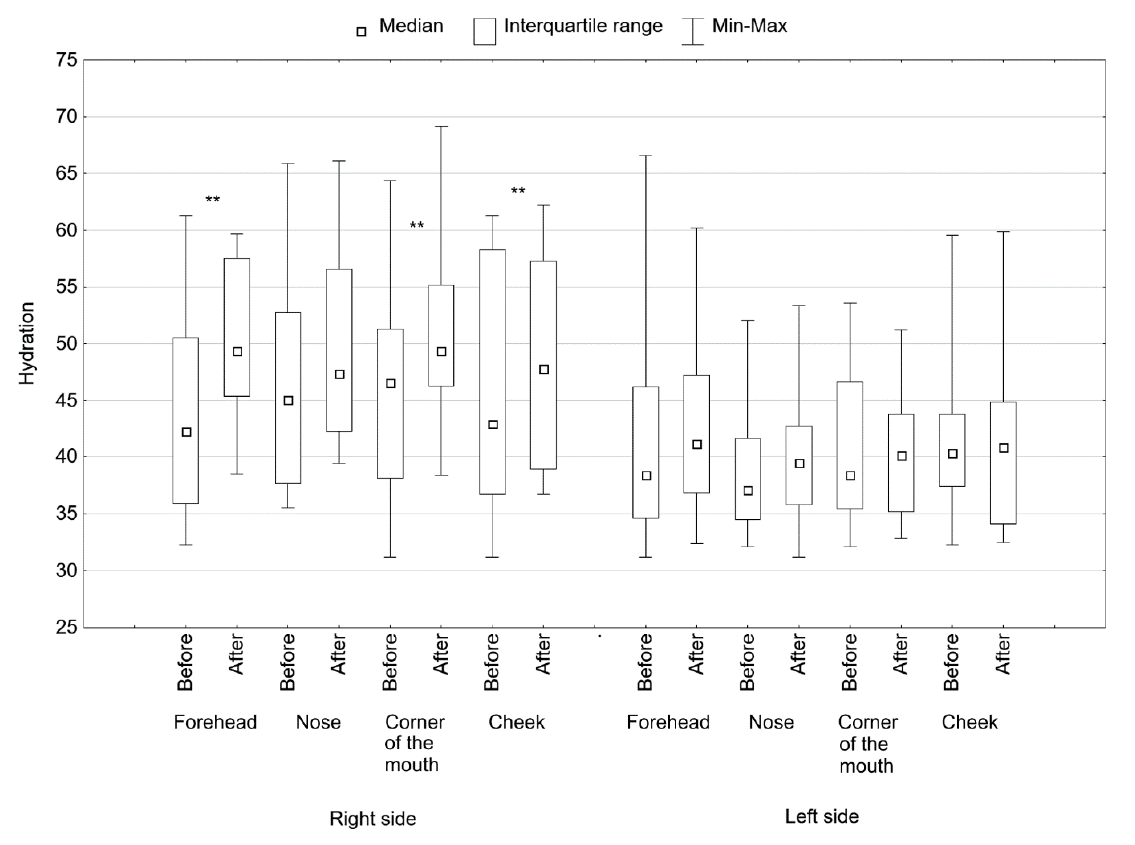
secretion value decreased by o 7.5 ug/cm 2 , respectively, ( p < 0.01) on the nose, by 10 µ g/cm 2 ( p < 0.05) around the corner of the mouth and by 11.5 ug/cm 2 ( p < 0.01) on the cheek. The microdermabrasion procedure and the application of 40% pyruvic acid on the right side of the face resulted in a statistically significant increase in the hydration of the stratum corneum in the forehead ( p < 0.01), the corner of the mouth ( p < 0.01) and the cheek ( p < 0.05) (Figure 3, Table 4). The median value of skin hydration increased by 7.2 in the forehead area, 2.3 in the nasal lobe, 3.2 in the corner of the mouth and 4.9 in the cheek area.